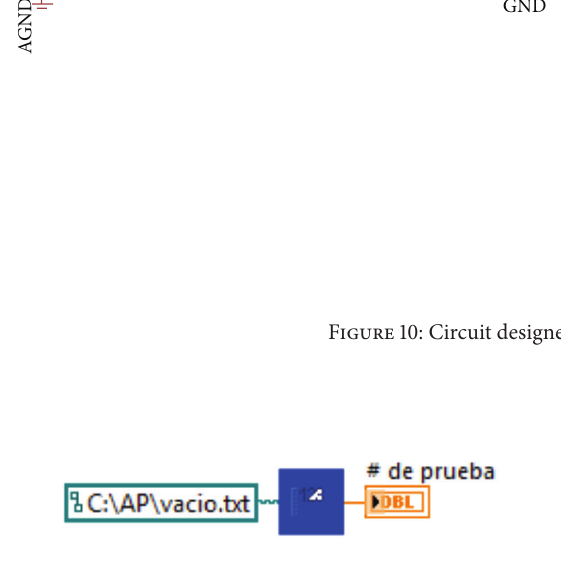
Figure 11: Test counter programming block.